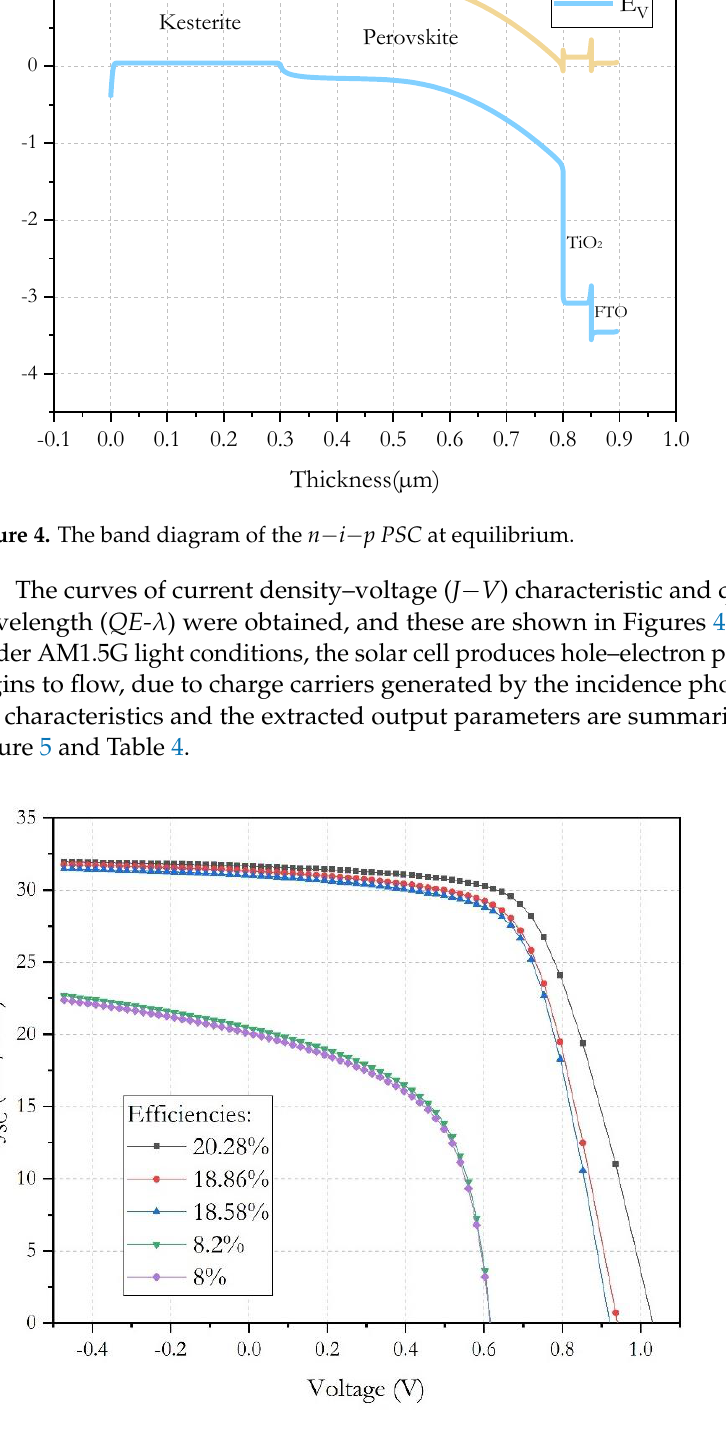
Figure 5. J − V characteristics of the n-i-p PSC Figure 5. J−V characteristics of the n-i-p PSC . Table 4. History of parameters of the simulations obtained in the solar cells.